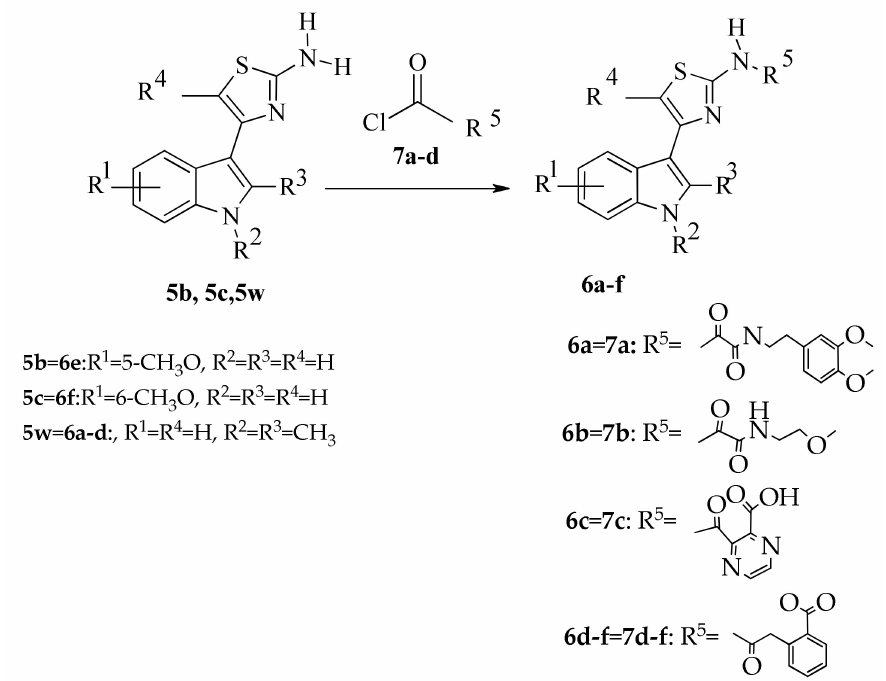
Scheme 2. Synthesis of indole-based thiazoles 6a-f by acylation of aminothiazoles 5b, 5c, 5w . Reagents and conditions: pyridine, 5h , stiurring